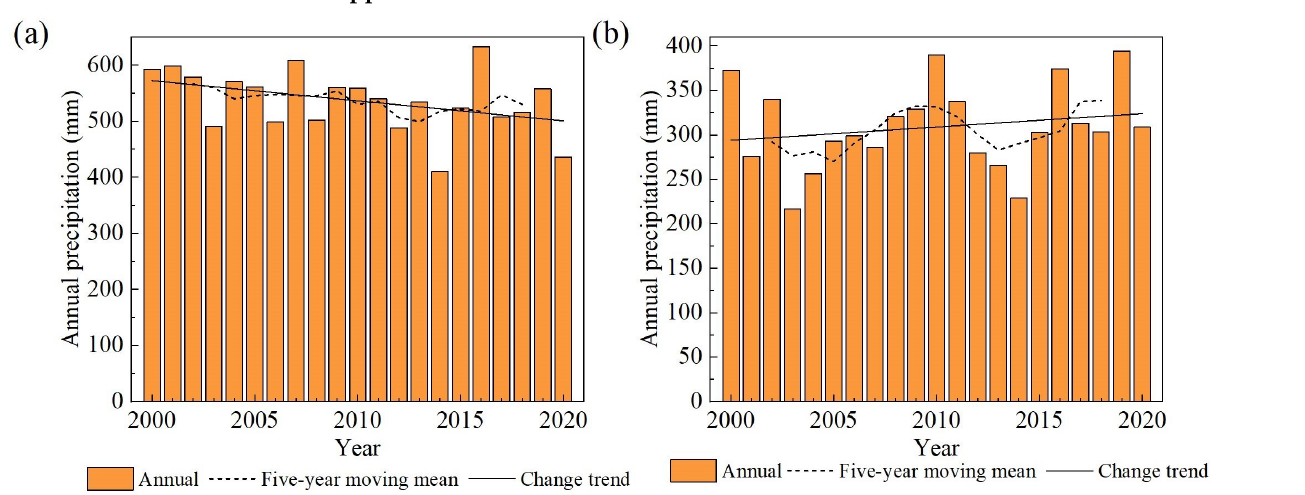
Figure A1. Precipitation in the upstream basins of lakes from 2000 to 2020 ( a ) Manas Lake; ( b ) Bosten Lake.